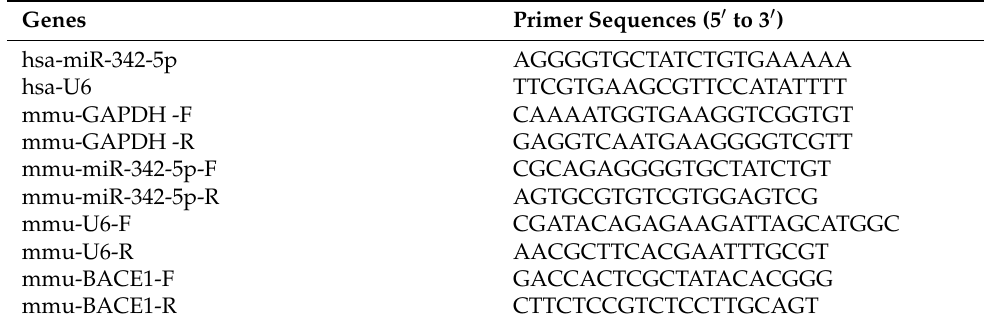
Table 2. Primers for qPCR assay in this study.